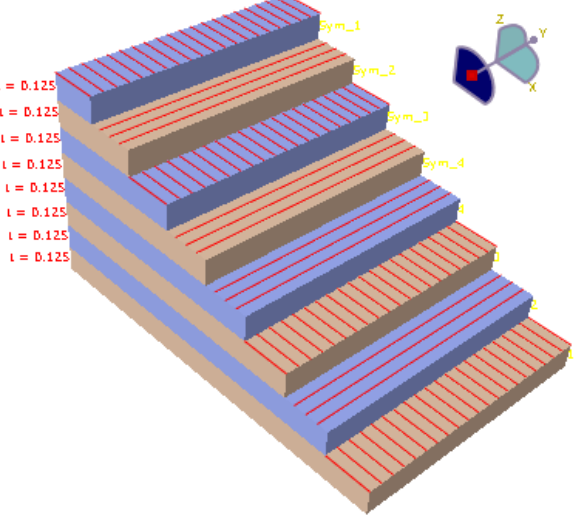
Figure 2: Fiber orientation of the laminate plate.